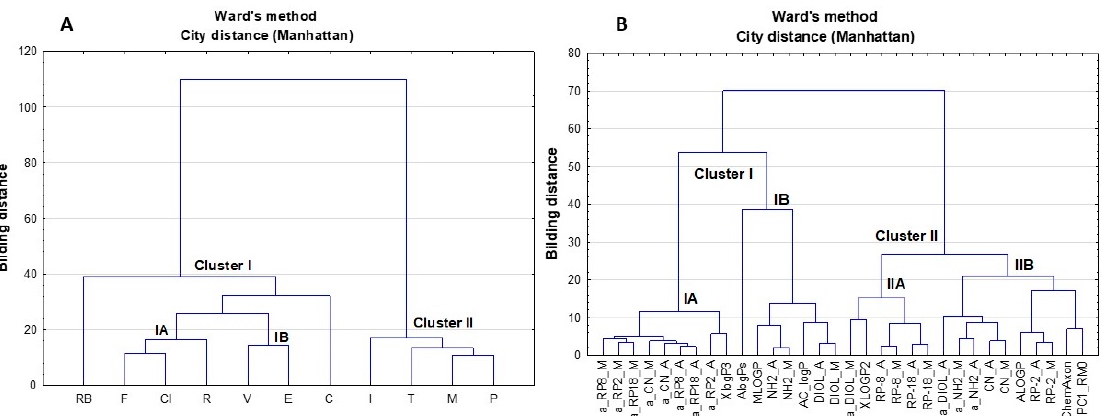
Figure 7. Dendrograms calculated on the basis of the established lipophilicity results for the studied substances using CA approach (( A ) objects, ( B ) variables).